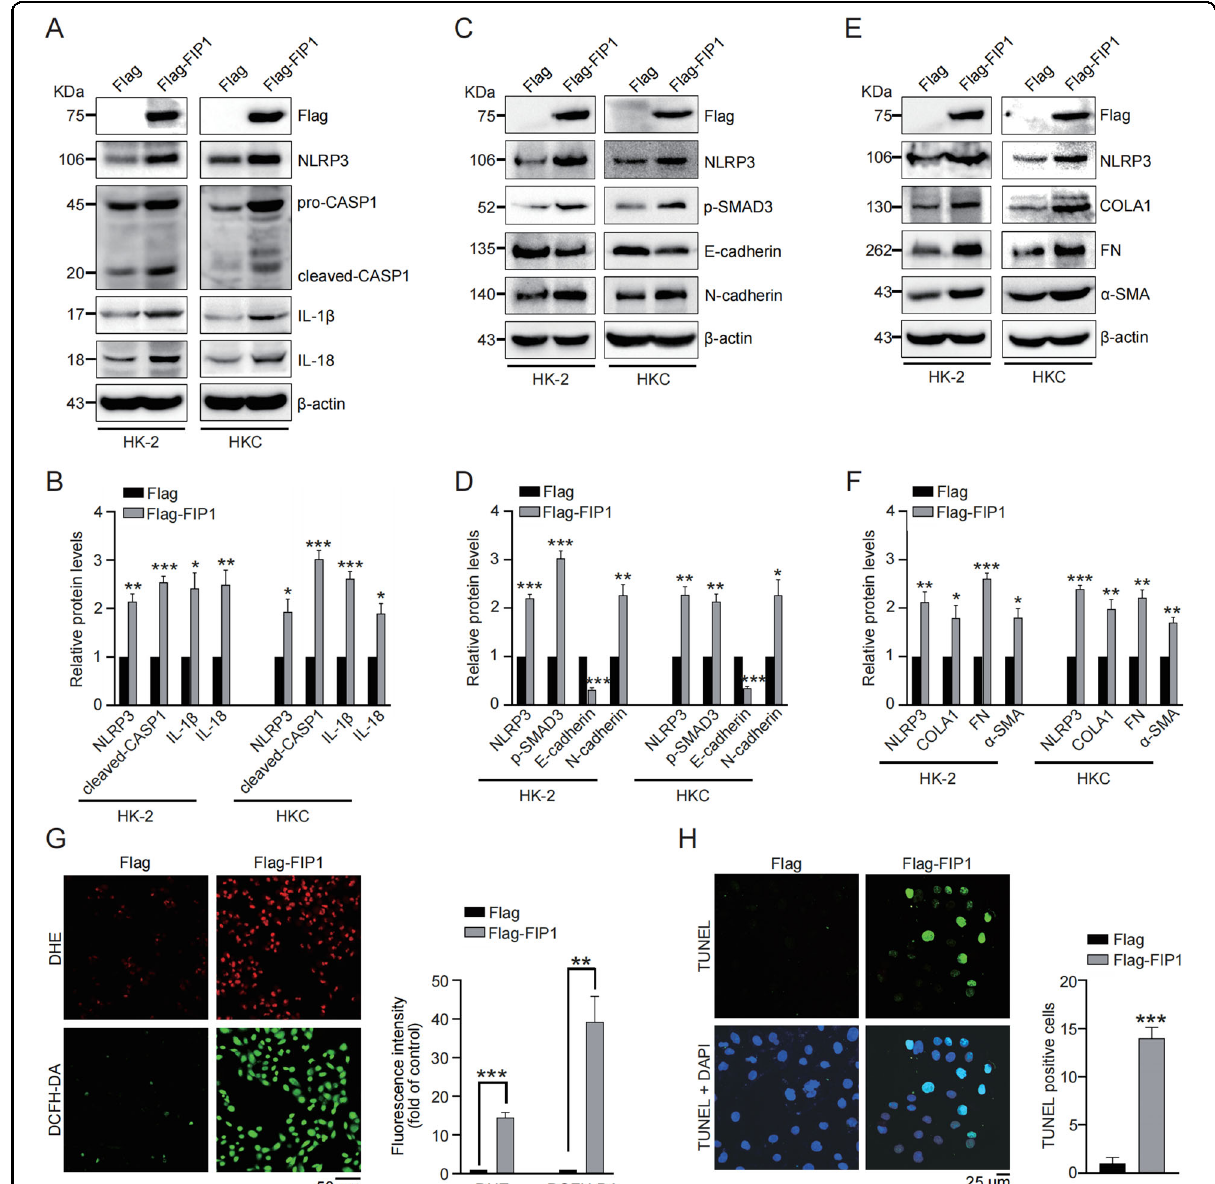
Fig. 5 FIP1 promotes in fl ammation, fi brogenesis, ROS production, and apoptosis in renal tubular epithelial cells. A Western blot was performed to determine the protein levels of Flag, caspase1, IL-1 β , and IL-18 in HK2 and HKC cells transfected with empty vector or Flag-FIP1 respectively. B Quantitative analysis of protein levels of caspase1, IL-1 β and IL-18 in HK2 and HKC cells transfected with empty vector or Flag-FIP1 respectively. C Western blot was performed to determine the protein levels of phospho-SMAD3, E-cadherin, and N-cadherin in HK2 and HKC cells transfected with empty vector or Flag-FIP1 respectively. D Quantitative analysis of protein levels of phospho-SMAD3, E-cadherin, and N-cadherin in HK2 and HKC cells transfected with empty vector or Flag-FIP1 respectively. E Western blot was performed to determine the protein levels of collagen I, fi bronectin, and α -SMA in HK2 and HKC cells transfected with empty vector or Flag-FIP1 respectively. F Quantitative analysis of protein levels of collagen I, fi bronectin, and α -SMA in HK2 and HKC cells transfected with empty vector or Flag-FIP1 respectively. G Representative images and quantitative analysis of DHE and DCFH-DA staining in HK2 cells transfected with empty vector or Flag-FIP1 respectively. H Representative images and quantitative analysis of TUNEL staining in HK2 cells transfected with empty vector or Flag-FIP1 respectively. * P < 0.05; ** P < 0.01; *** P < 0.001; All data represent the mean ± SEM obtained from three independent experiments. Student ’ s t